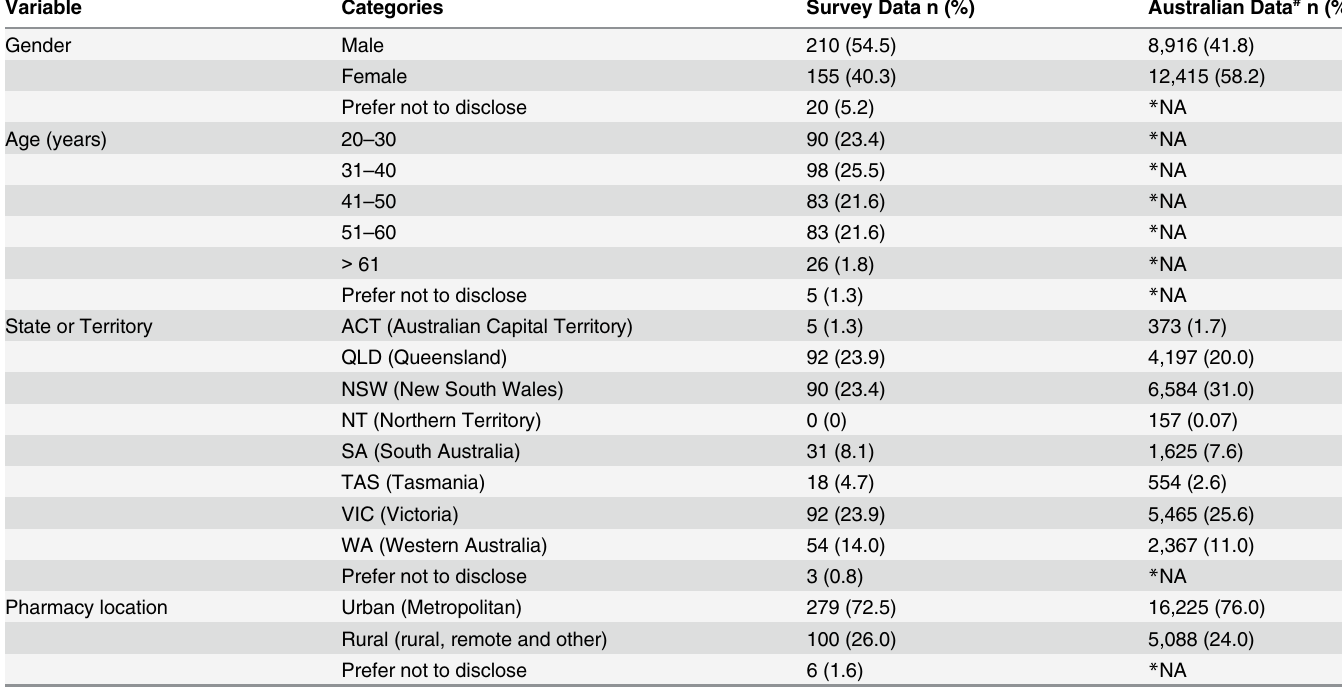
Table 1. Demographic characteristic of the participants (n =